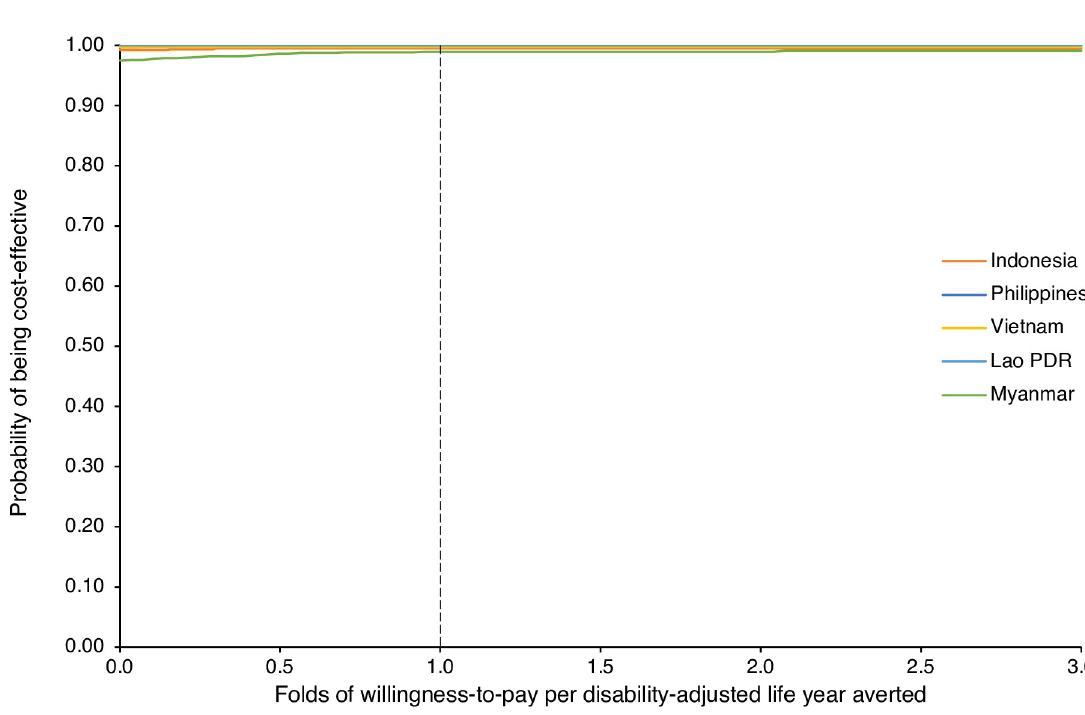
Fig 2. Cost-effectiveness acceptability curves of improving access to snake antivenom in ASEAN countries. Probabilities of full access to snake antivenom being cost-effective compared to current access in each ASEAN country at varying willingness-to-pay thresholds based on 1,000 iterations of a probabilistic sensitivity analysis are